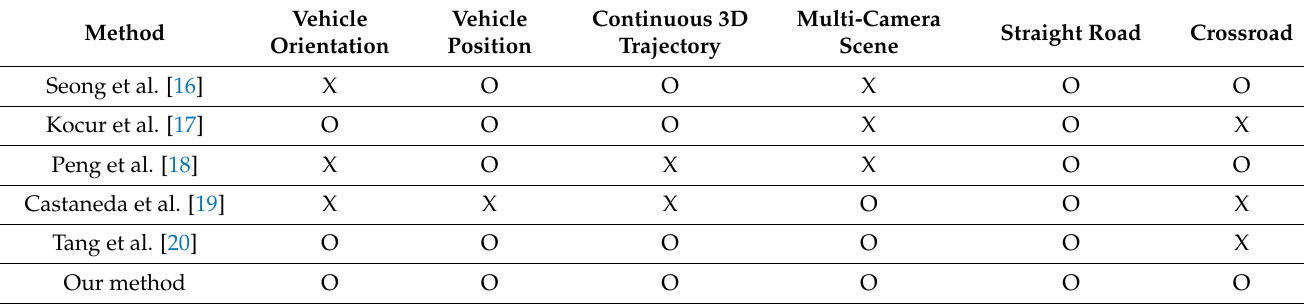
Table 1. Comparison of different 3D vehicle trajectory extraction algorithms.